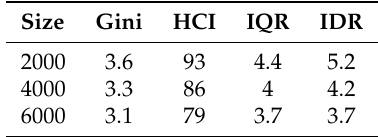
Table 7. Relative RMSE (%) of each parameter without applying PSA. Size